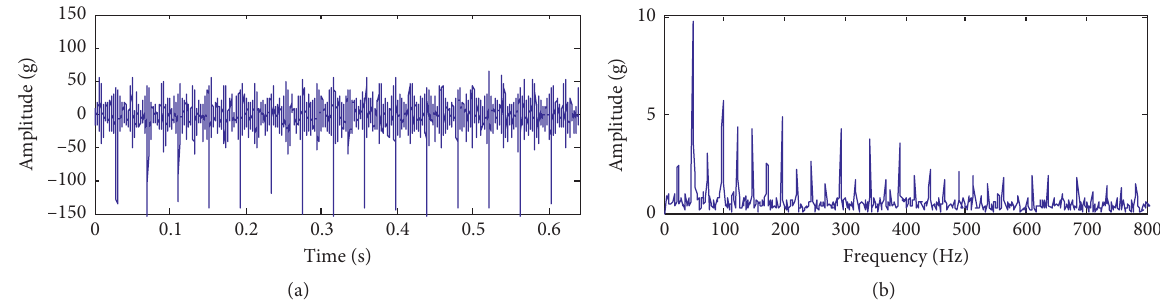
Figure 15: Comparison results of experimental signal by the MED method: (a) the waveform of deconvolution signal; (b) the envelope spectrum of deconvolution signal.